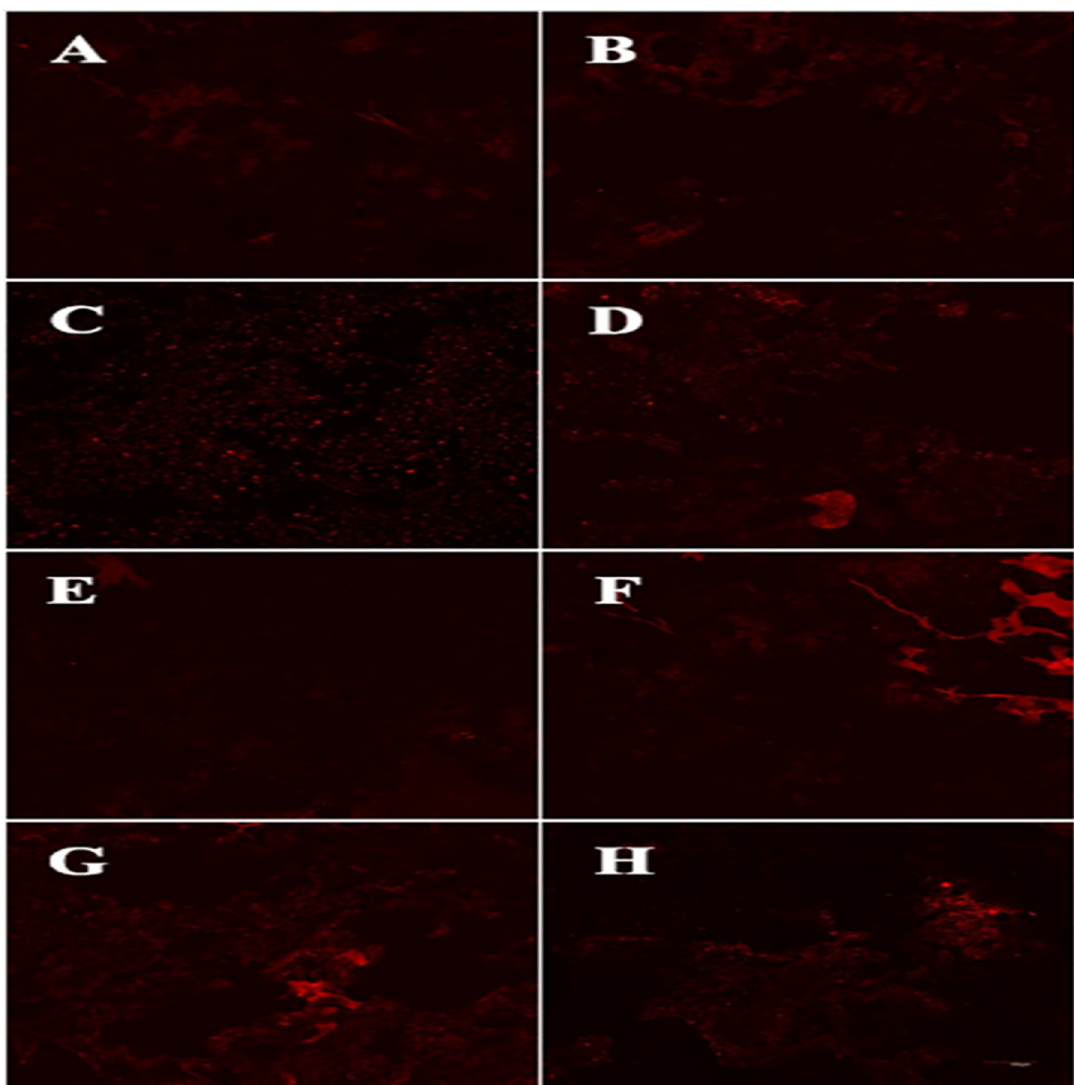
Figure 4. CLSM images of fried BBFNs using fresh and preheated frying oils. All of the images were taken at 10 × magnification in fluorescence mode. ( A ) Fresh rapeseed oil; ( B ) preheated rapeseed